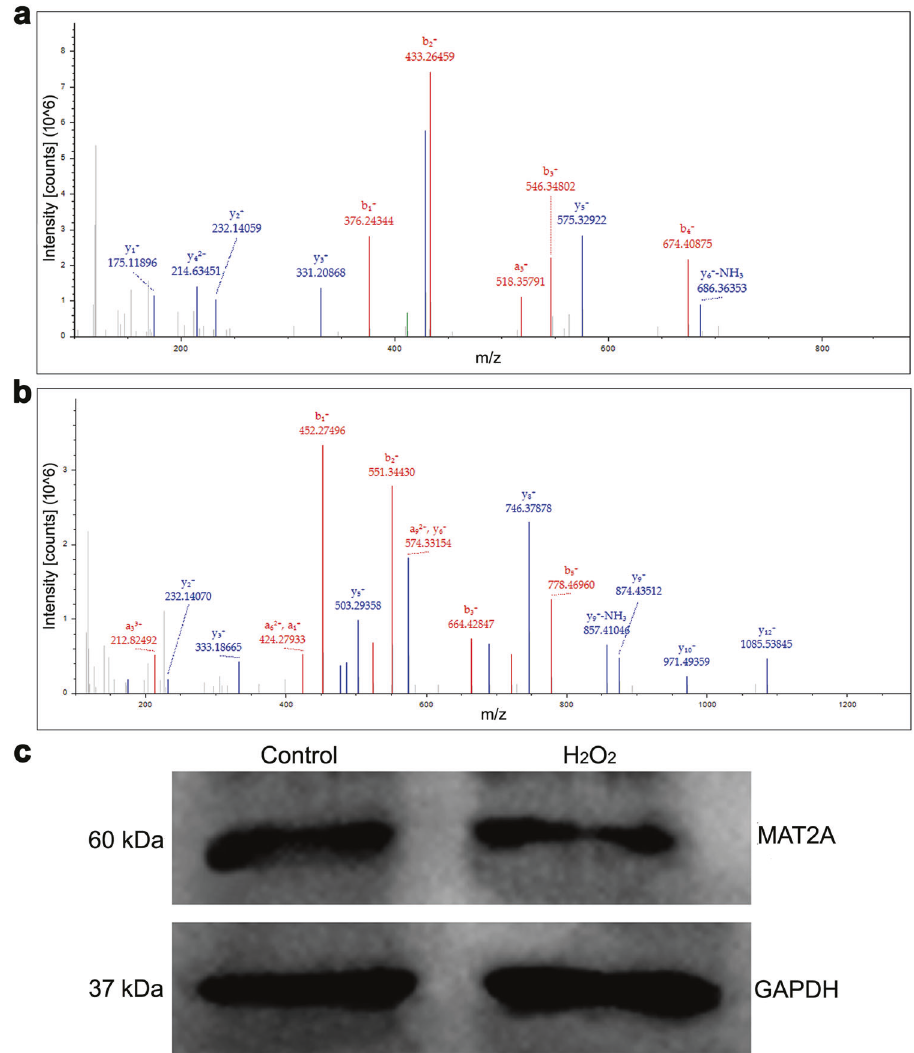
Fig. 5 Identi fi cation of differentially expressed proteins in response to oxidative damage by iTRAQ. a , b MS/MS spectra used for the identi fi cation of H2A and MAT2A, respectively. c MAT2A protein levels were detected by western blotting to validate the iTRAQ results. GAPDH was used as a normalization control. Molecular weights are indicated on the left: MAT2 (60 kDa) and GAPDH (37 The mRNA expression of Nucleolin , n-Myc , Rpl15 , Rpl36a , hnRNP K , β -Catenin , and TGF- β 1 was signi fi cantly lower in the 1-cell and 8-cell embryos of the H 2 O 2 /EGCG-treated group than in those of the H 2 O 2 -treated group ( P < 0.05), suggesting that EGCG treatment regulated the abnormal expression of ribosome-/tumor-related genes in oxidatively damaged IVF embryos. Furthermore, the levels of most ribosome-/tumor-related genes tended to decrease with the development of oxidatively damaged embryos but were still signi fi cantly higher than those in the control group ( P < 0.05). Only Rpl15 expression increased remarkably from the 1-cell to 8-cell stages, suggesting that Rpl15 may be the most critical ribosomal protein in carcinogenesis in IVF-derived offspring. The Rpl15 level was restored to the normal level by EGCG supplementation under oxidative stress.